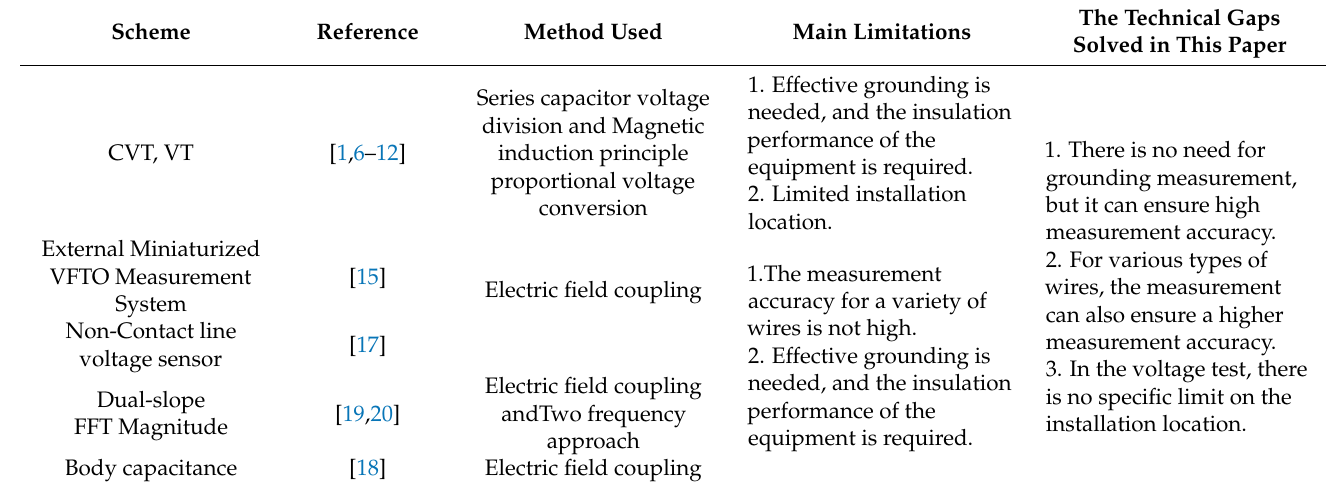
Table 1. Comparison of voltage measurement